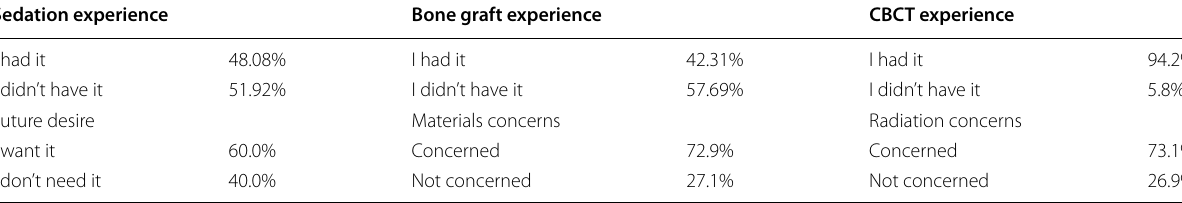
Table 2. Experience, desire and concerns on specific procedures by patients who received implant Sedation